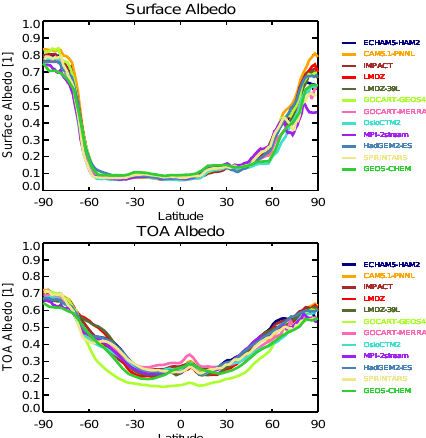
Fig. A2. Annual zonal-mean broadband short-wave surface and top-of-atmosphere albedos for experiment FIX0 (AOD=0.0, SSA=0.8, ANG=1.0).